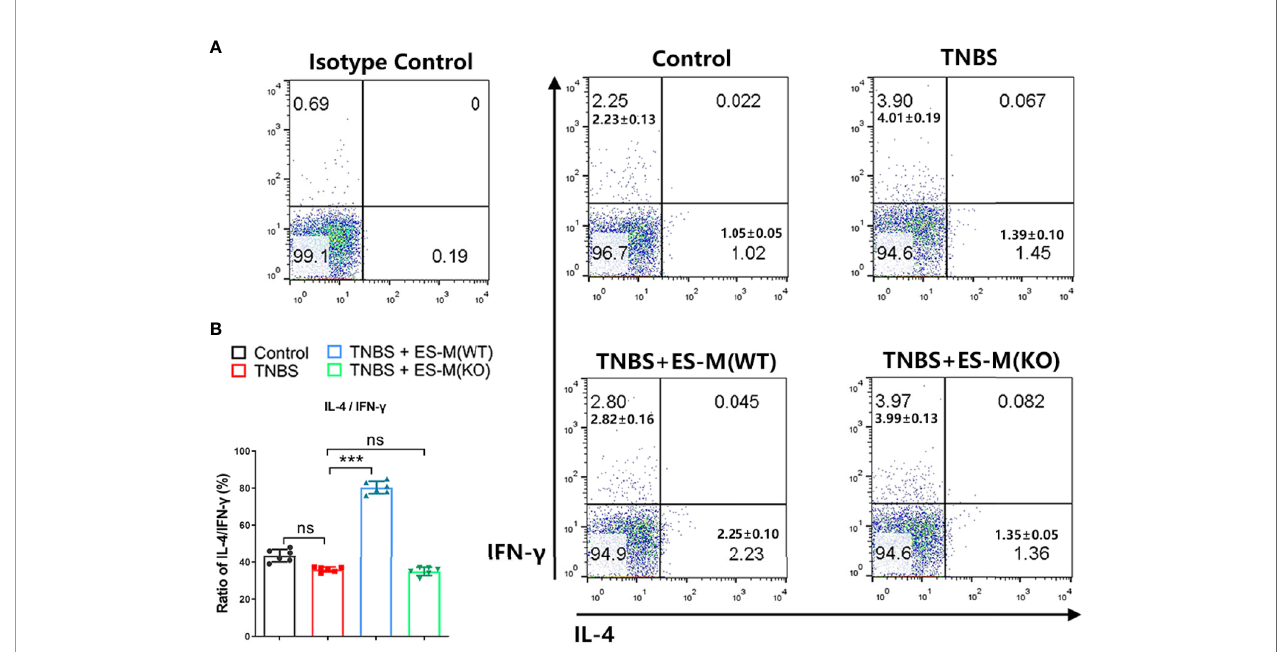
FIGURE 5 | Differentiation of CD3 + CD4 + IFN- g + or IL-4 + T cells of T. spiralis ES – induced wild type (WT) or Nrf2 KO macrophages (ES-M) on TNBS-induced colitis. (A) CD3 + CD4 + T cells were gated. IFN- g + , IL-4 + T cells populations were determined. (B) The ratio of IL-4/IFN- g was shown. Data are shown as the means ± SD (three independent experiments) of each group (n=6). ***p < 0.001, ns, no signi fi cance, as indicated by line (one-way ANOVA with Tukey ’ s posttest). These fi gures are representative of three independent experiments.